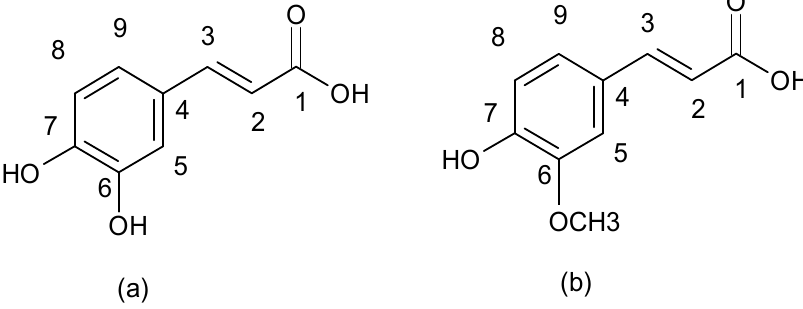
Figure 7. Chemical structure of ( a ) caffeic acid and ( b ) ferulic